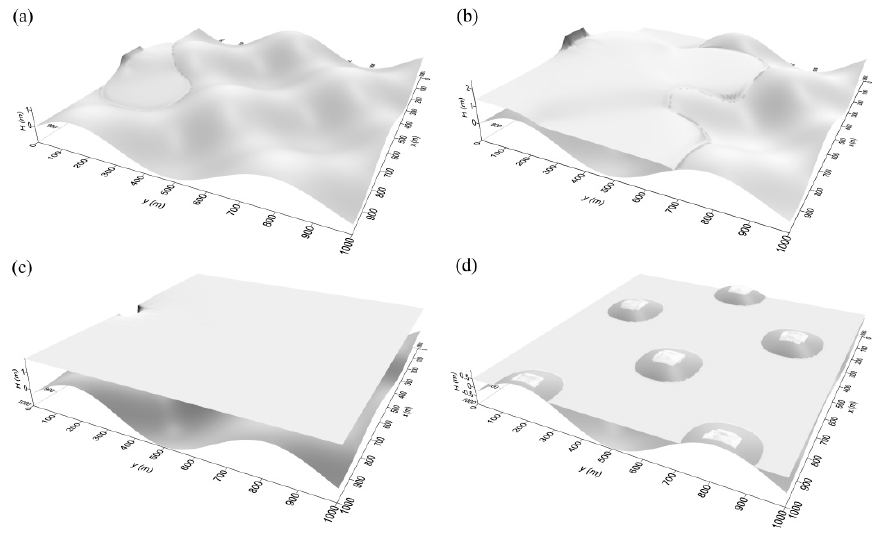
Figure 9. Three dimensional view of water surface propagation over the bottom (for 200 × 200 elements, ∆ x = 5 m, ∆ t = 5 s) at selected times: t = 500 s ( a ), t = 1200 s ( b ), t = 3900 s ( c ), t = 30,000 s ( d ).